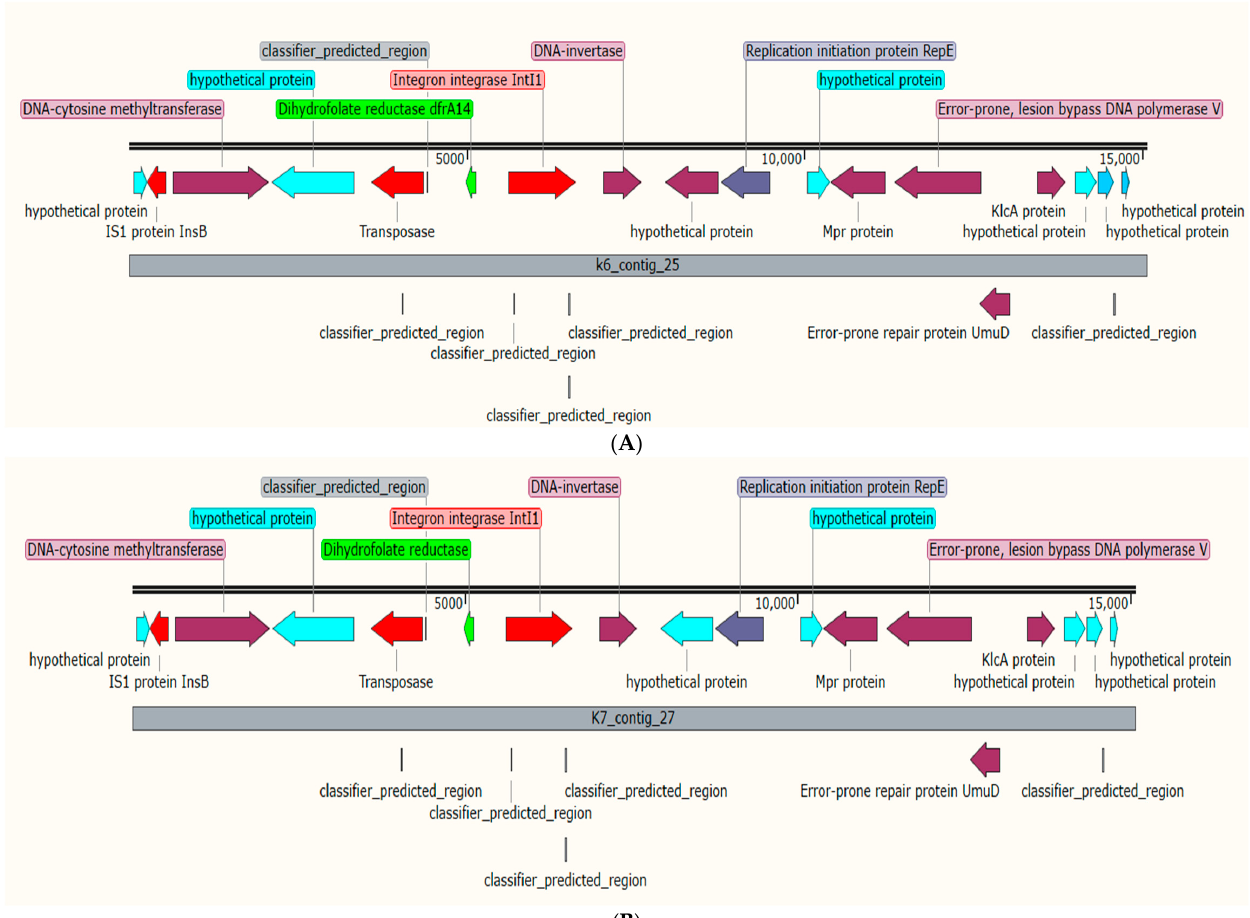
Figure 3. Gene cassettes in plasmid p C1K6P0122-2 of isolates K6 ( A ) and K7 ( B ); the gene cassettes were the trimethoprim-resistant gene dfrA14 (green), integron integrase ( IntI1 ) (red), insertion sequence (IS1) (red), transposase protein (red), and replication initiation protein (RepE) (grey).